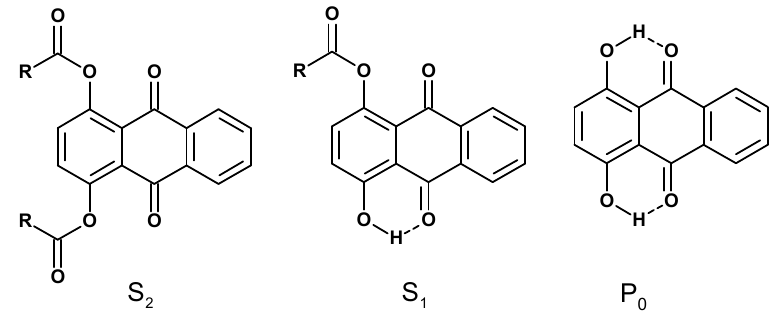
Figure 8. Molecular structures of the diester (S 2 ) monoester (S 1 ) and quinizarin product (P 0 ).